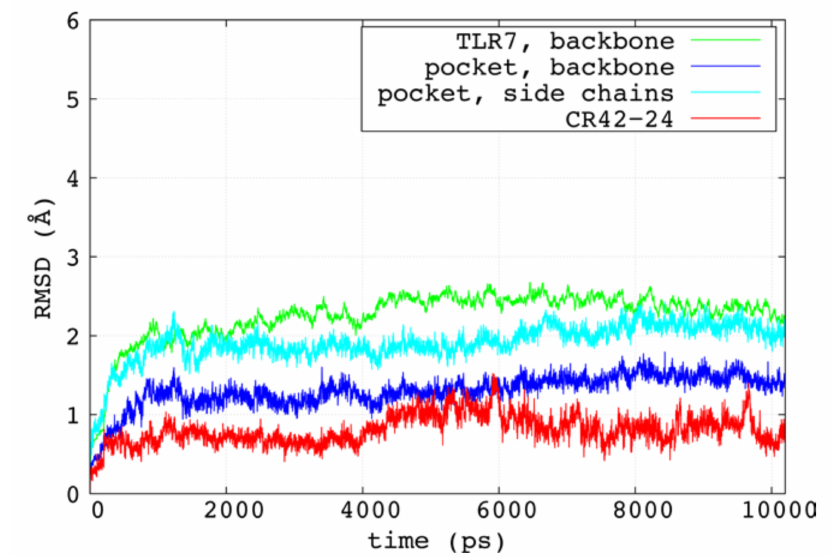
Figure 4. RMSD trends for the TLR7 backbone atoms (green), the backbone atoms of the binding pocket residues (blue), the side chain atoms of the binding pocket (cyan) and the heavy atoms of the CR42-24 molecule (green), calculated between the initial phase of restraint release and the end of the 10 ns-long production simulation (10.2 ns of total time).